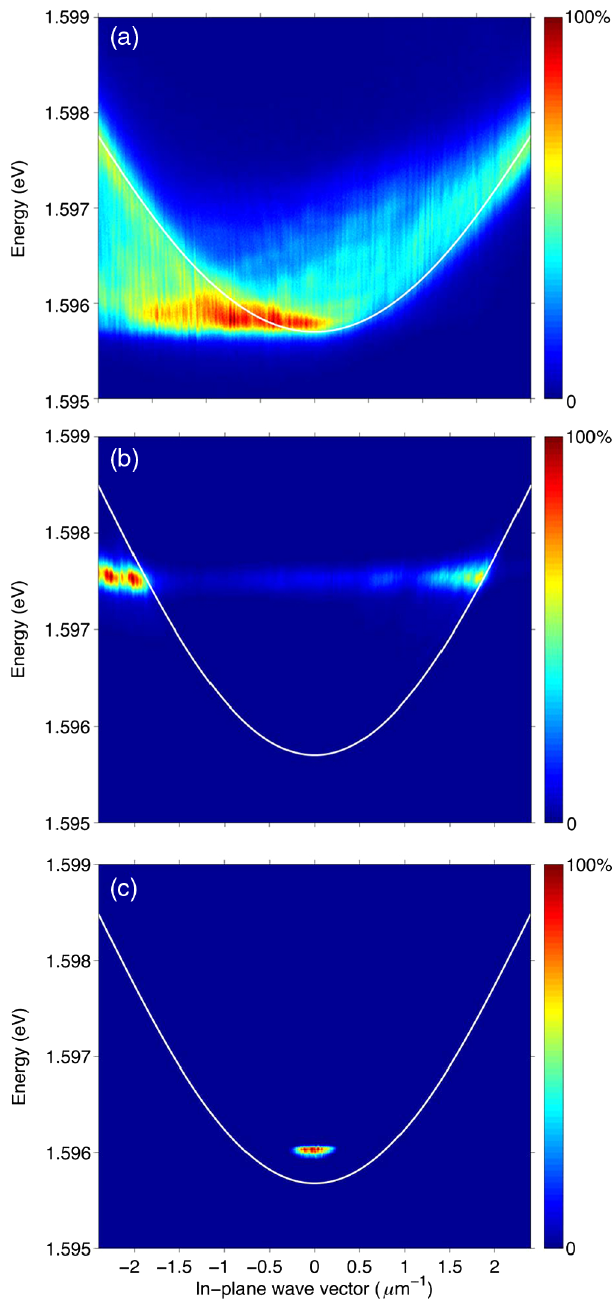
FIG. 1. Momentum-space-resolved polariton distribution as power is increased. The polaritons are created by an incoherent pump in a spot of diameter 12 (cid:2) m on the sample with (cid:3) ¼ (cid:1) 3 : 2 meV . (The polaritons are mostly photonlike.) The white parabola gives the energy dispersion of the polaritons at the point of creation in the low-density limit. (a) 1-mW pump power. The smearing of the distribution toward the left corresponds to the momentum gained by the particles as they accelerate downhill in the gradient of energy created by the variation of cavity thick- ness. (b) The same excitation conditions but at a pump power of 34 mW. The distribution has become monoenergetic and is shifted to the blue, as discussed in the text. (c) The same excitation conditions but at a pump power of 44